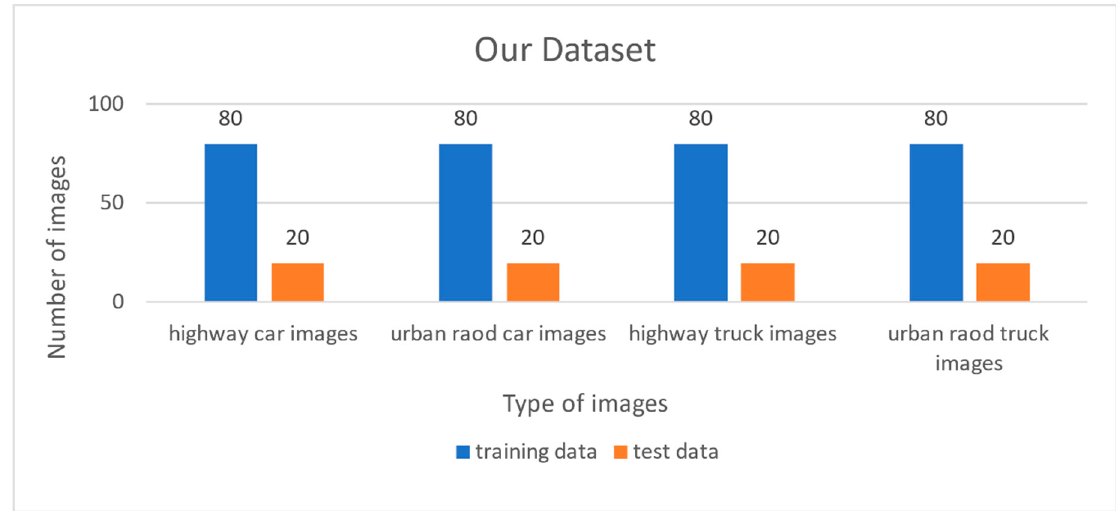
Figure 10. Our road images data set includes four types of images, divided into the training data and test data.